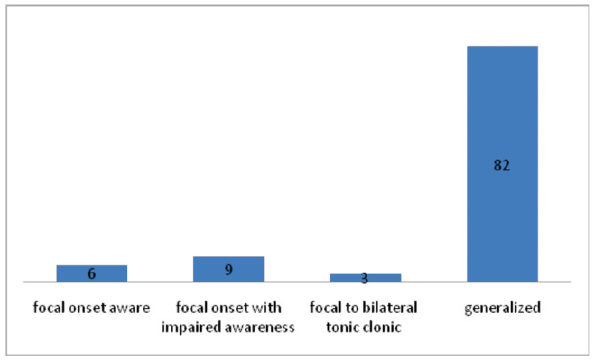
Table 6: Proportion of patients on one, two, three